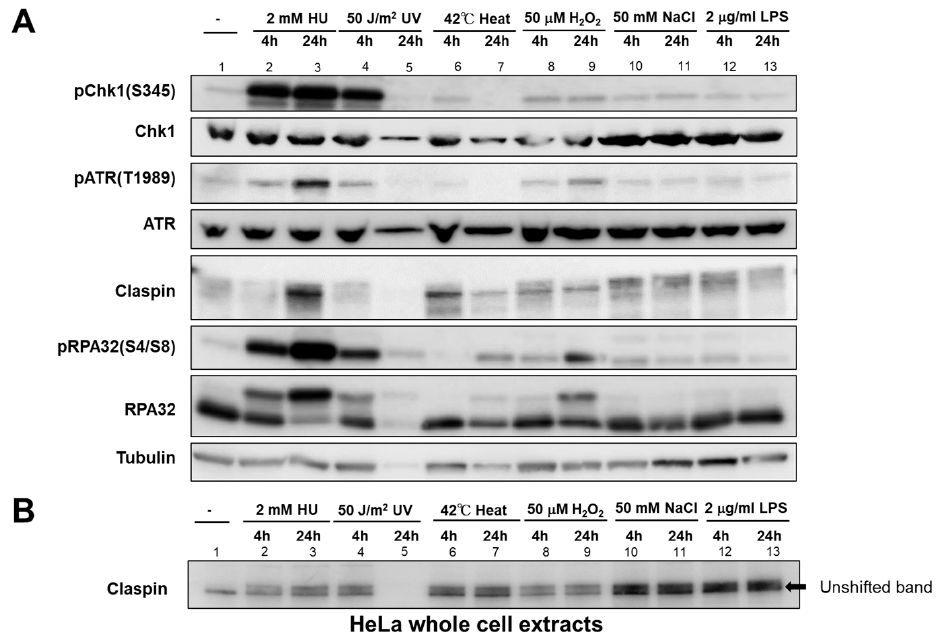
Figure 4. Effect of various biological stresses on checkpoint- and DNA damage-related factors in HeLa cells. HeLa cells were treated with indicated stresses for the time indicated. ( A ) The whole cell extracts were analyzed by Western blotting with the antibodies indicated. ( B ) Samples were analyzed on a low concentration gel to improve the separation of phosphorylated forms. The unshifted form of Claspin is indicated by an arrow. Lane 5, Protein is not detected due to cell death induced by UV. ATR, the upstream PIKK (Phosphatidylinositol 3-kinase-related kinase), is required for Chk1 activation. Phosphorylation of ATR at T1989 is an indicator of ATR activation. ATR was activated not only by HU and UV, but also by H 2 O 2 , salt, and LPS, albeit at a